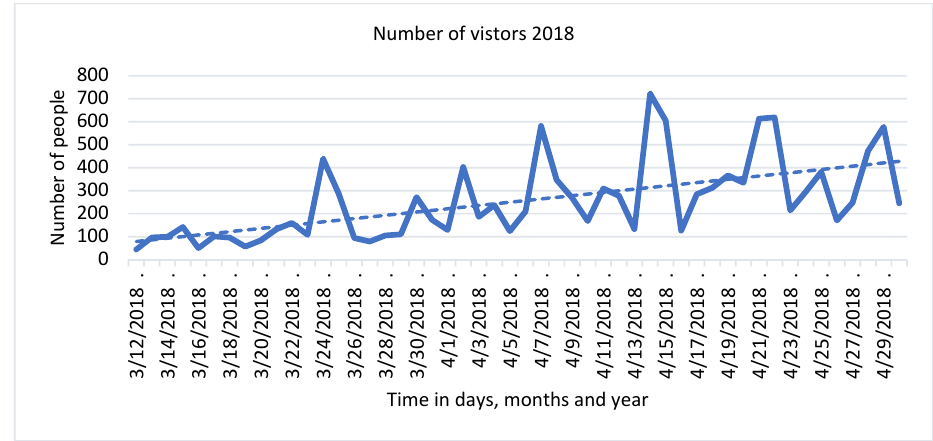
Figure A3. Recorded number of visitors per day in three months in 2017.